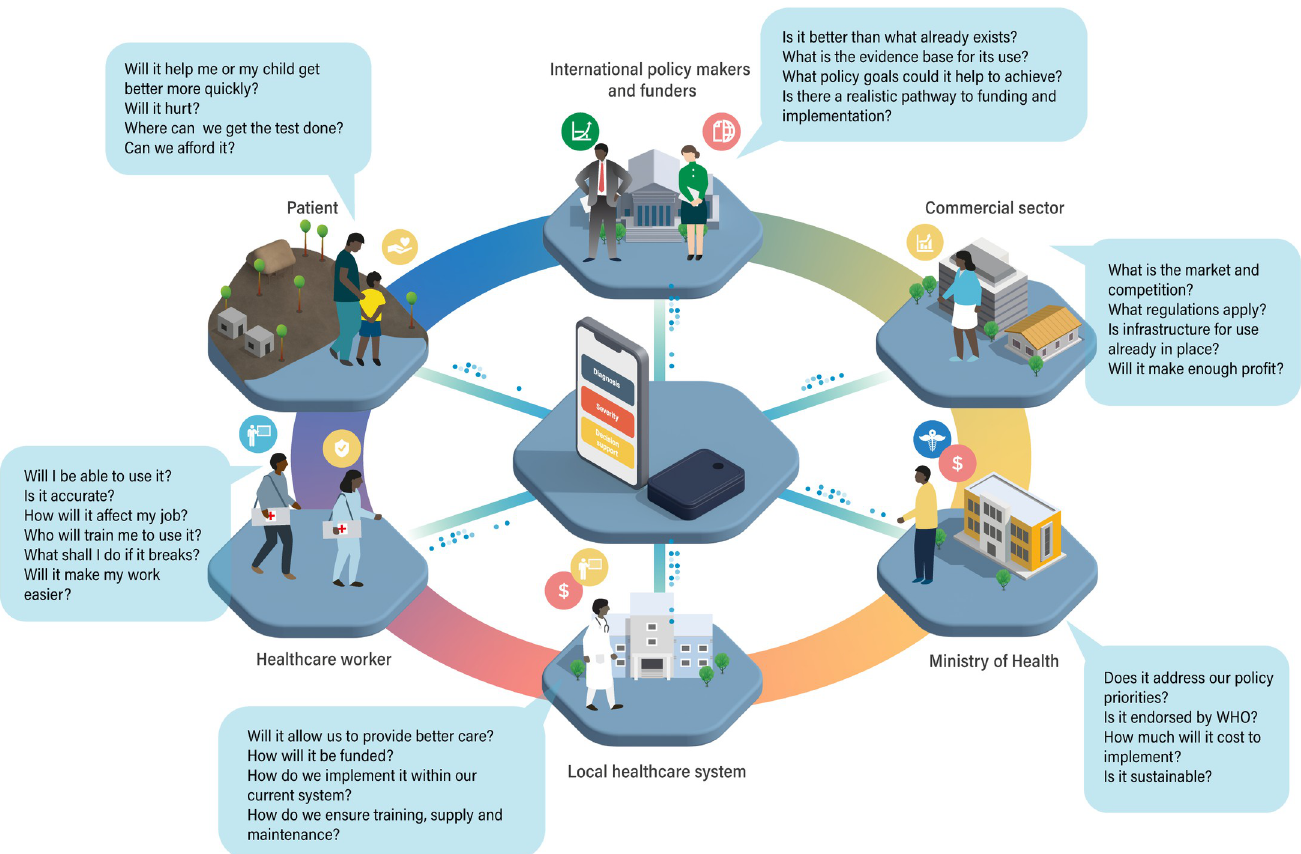
Fig 4. Understanding the perspective of users and stakeholders. To produce new digital diagnostics that will be widely used, it is important to understand the perspectives of all stakeholders involved in and impacted by their implementation. Understanding the perspectives of patients and healthcare workers is important, but consideration must also be given to the broader health system, government organisations, the commercial sector, international funders, and policy makers. This may start with mapping who the stakeholders are, identifying their needs, discussing their expectations for a new diagnostic, and engaging them throughout product design, development and evaluation in a codesign